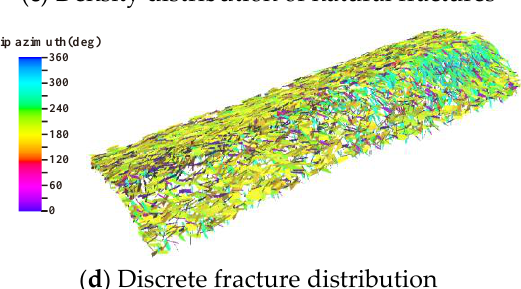
Matrix Figure 9. Schematic of fracture grid and matrix grid conduction patterns. The change in stress during the development of the gas reservoirs was simulated, without considering the influence of temperature change and capillary force. The target formation is a high-temperature and high-pressure gas reservoir; the initial formation pressure gradient is about 1.8 MPa/100 m, and the converted reservoir pore pressure is about 120 MPa~123 MPa. The water production is small and can be considered as no edge and bottom water. The gas-water interface is set at about 7000 m in the simulation, below the main force level. The rest of parameters are shown in Table 2. Table 2. The parameters of the seepage numerical model for the target formation. Parameters